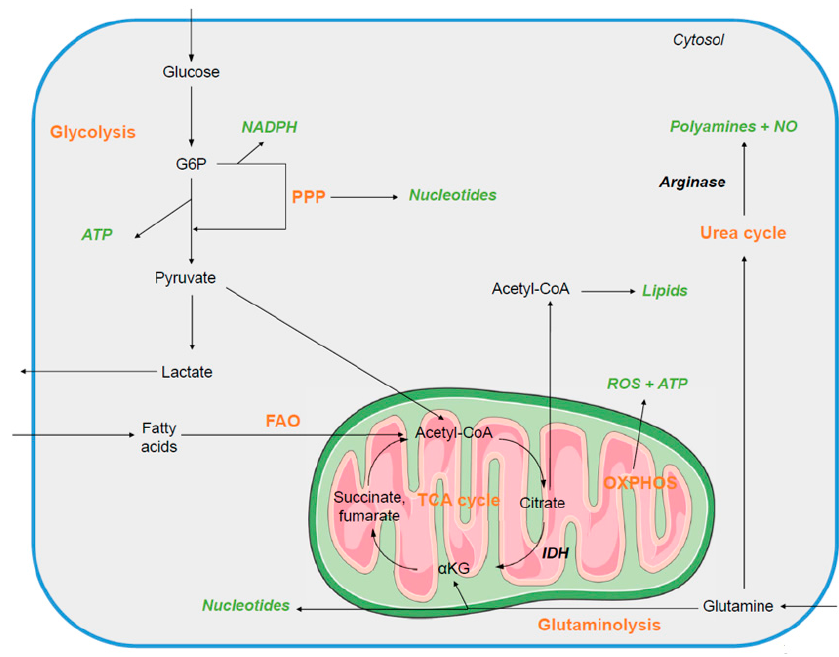
Figure 1. The primary metabolic pathways in quiescent immune cells. The main catabolic pathways (orange) that contribute to the production of macromolecules or metabolites (green) in quiescent mammalian immune cells are the mitochondrial tricarboxylic acid (TCA) cycle and oxidative phosphorylation (OXPHOS) for ATP synthesis, fatty-acid oxidation (FAO), glutaminolysis, and urea cycle.